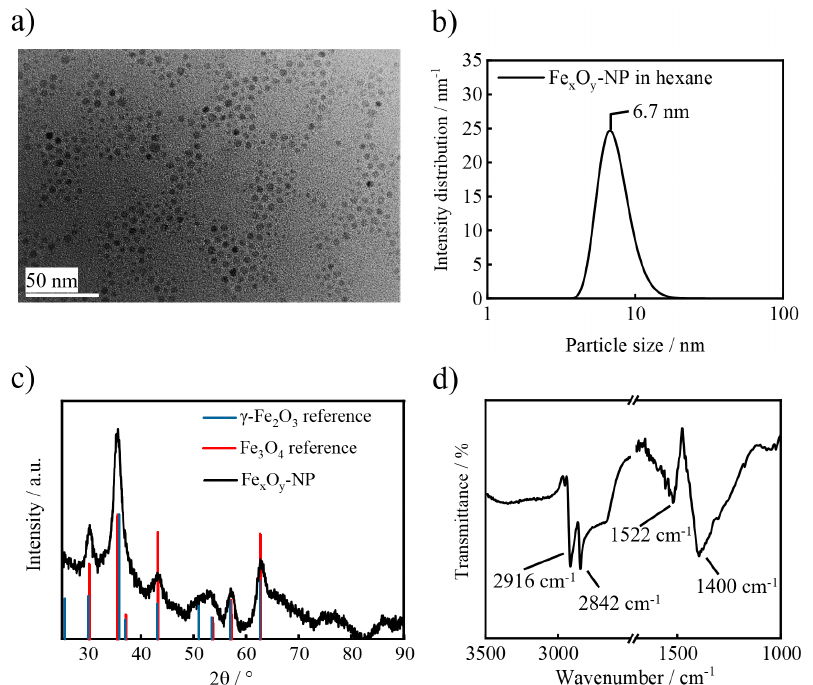
Figure 2. ( a ) Representative TEM image, ( b ) dynamic light scattering (DLS) result, ( c ) X-ray diffraction (XRD) diffractogram with a reference pattern of maghemite γ -Fe 2 O 3 and magnetite Fe 3 O 4 and ( d ) FT-IR spectrum of Fe x O y -NPs.